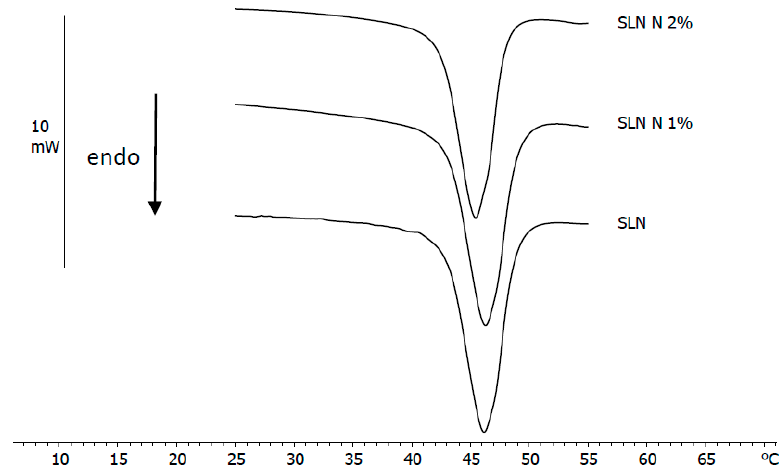
Figure 2. Calorimetric curves, in heating mode, of unloaded SLN, 1% Naringenin-loaded SLN (SLN N 1%), and 2% Naringenin-loaded SLN (SLN N 2%).